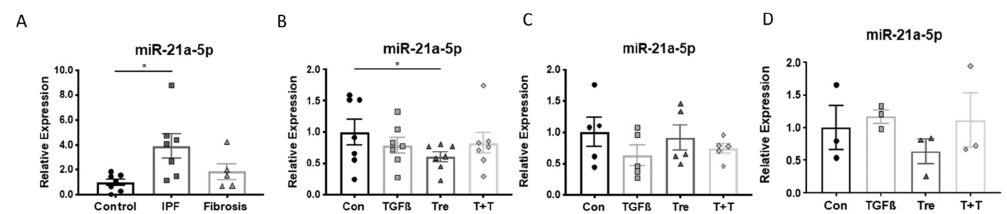
Figure 4. Disease-specific expression of miR-21a-5p and its modification by TGF- β 1 and treprostinil. ( A ) MiR expression was determined in cells of controls ( n = 7), IPF patients ( n = 7), and interstitial lung fibrosis ( n = 5). ( B ) Modification of miR-21a-5p by TGF- β 1 and treprostinil in control cells, ( C ) in IPF cells, and ( D ) in interstitial lung fibrosis cells. Bars represent mean ± SEM. * indicates p < 0.05. TGF β : TGF- β 1 (10 ng/mL); Tre: treprostinil (1 × 10 –8 M); T+T: TGF- β 1 (10 ng/mL) plus treprostinil (1 × 10 –8 M).